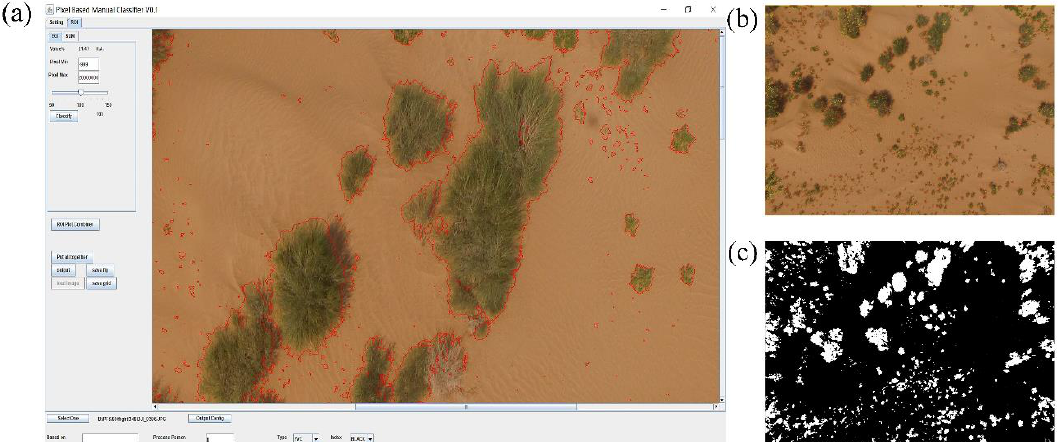
Figure 3. Operation interfaces of PixelClassifier. The threshold value ranges from 0 to 150, and the best classification result is determined according to visual discrimination. The threshold range in this classification process is 70–120. ( a ) Photo with a threshold of 101 that can achieve the best classification effect; the extracted vegetation coverage is 21.47%. The classification results are output in three forms: ( b ) colour map, ( c ) binary map in which white represents vegetation and black represents bare land, and text.